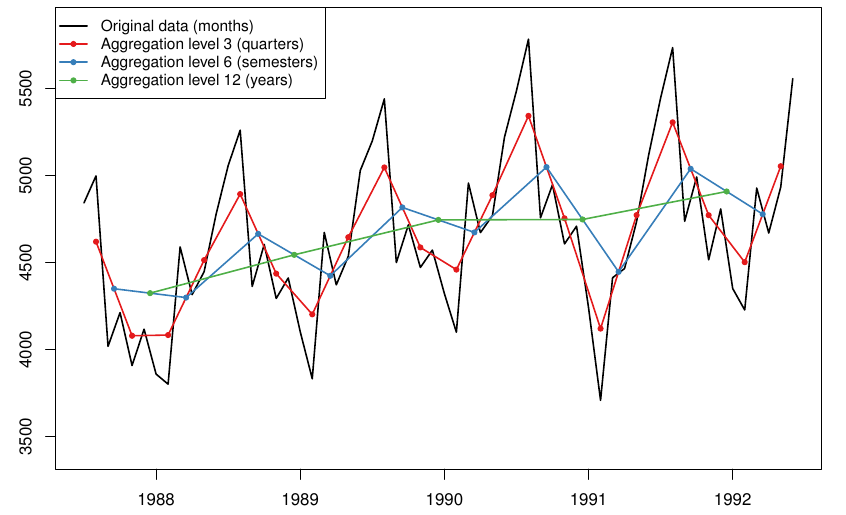
Figure 2. A visual example where multiple new temporally aggregated time series are created based on the original data. The monthly data (black line) are temporally aggregated to quarterly (red line), semesterly (blue line), and yearly (green line)